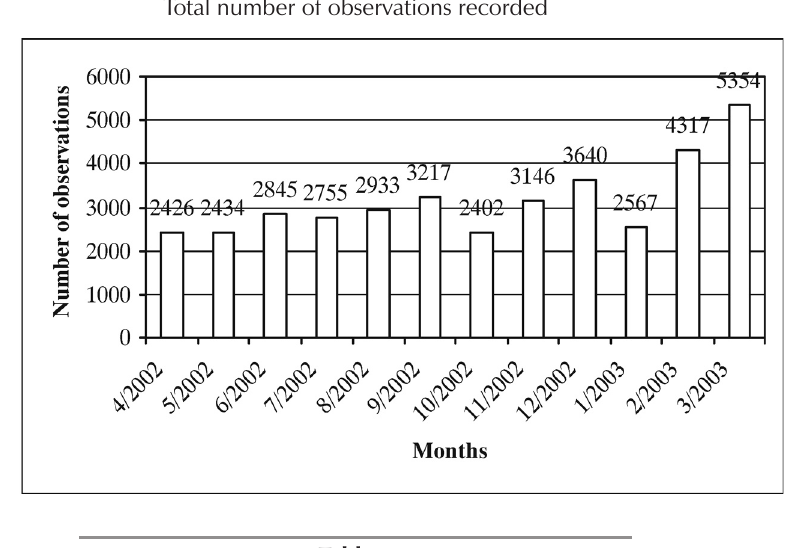
Total number of observations recorded